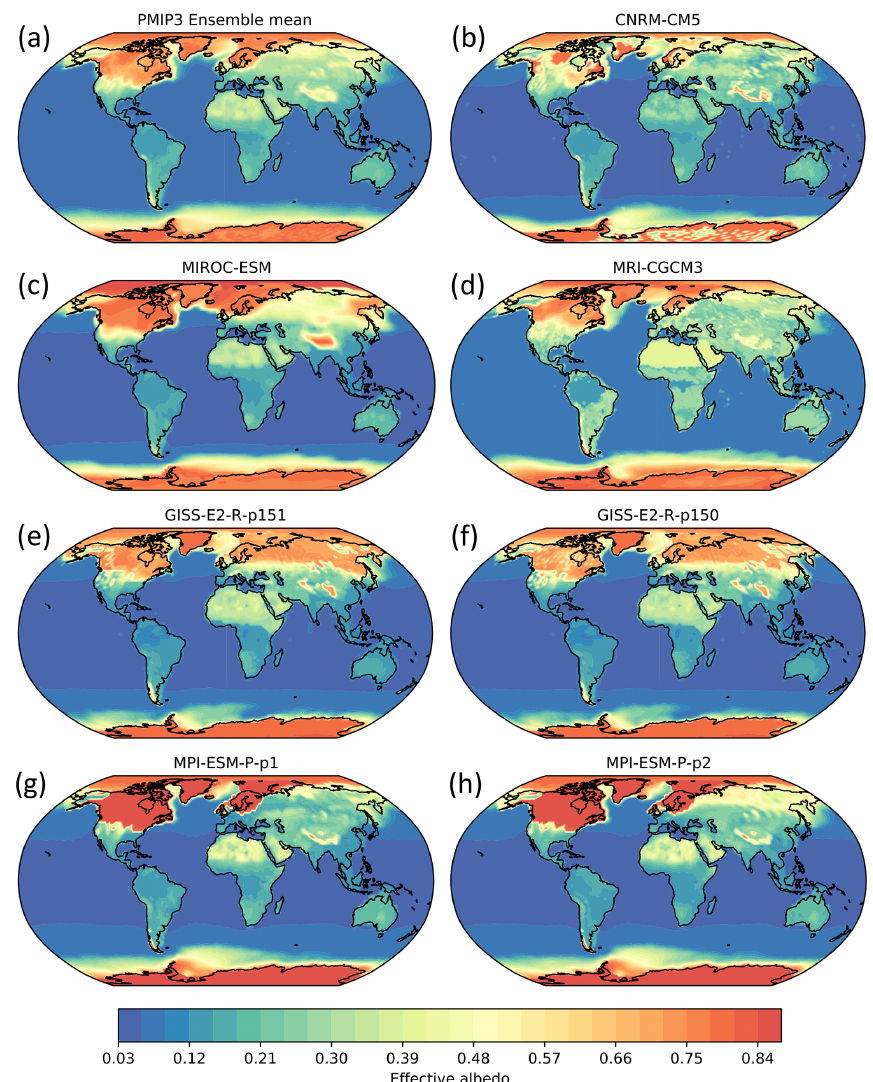
Figure 7. Maps of the effective surface albedo of ( b to f ) several PMIP3 models and comparison with (a) the PMIP3 ensemble mean. The ensemble mean excludes the variants GISS-E2-R-p151 and MPI-ESM-P-p2, as they were excluded in the ensembles of Schmidt et al. (2014) and Renoult et al.